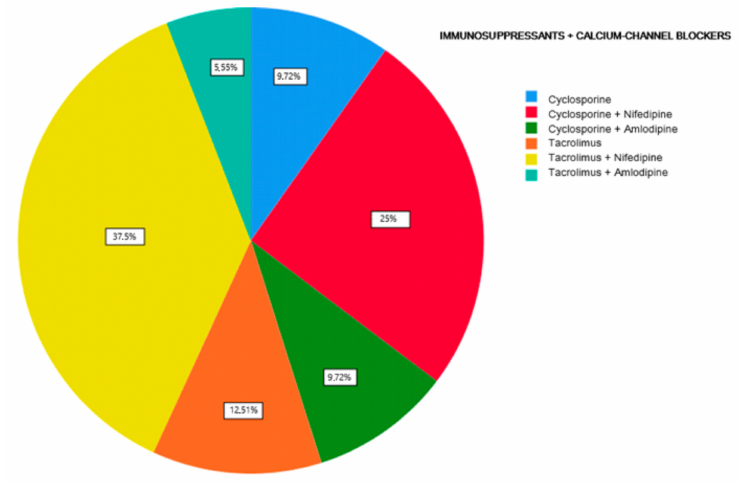
Figure 3. Percentage distribution of immunosuppressive therapies + calcium-channel